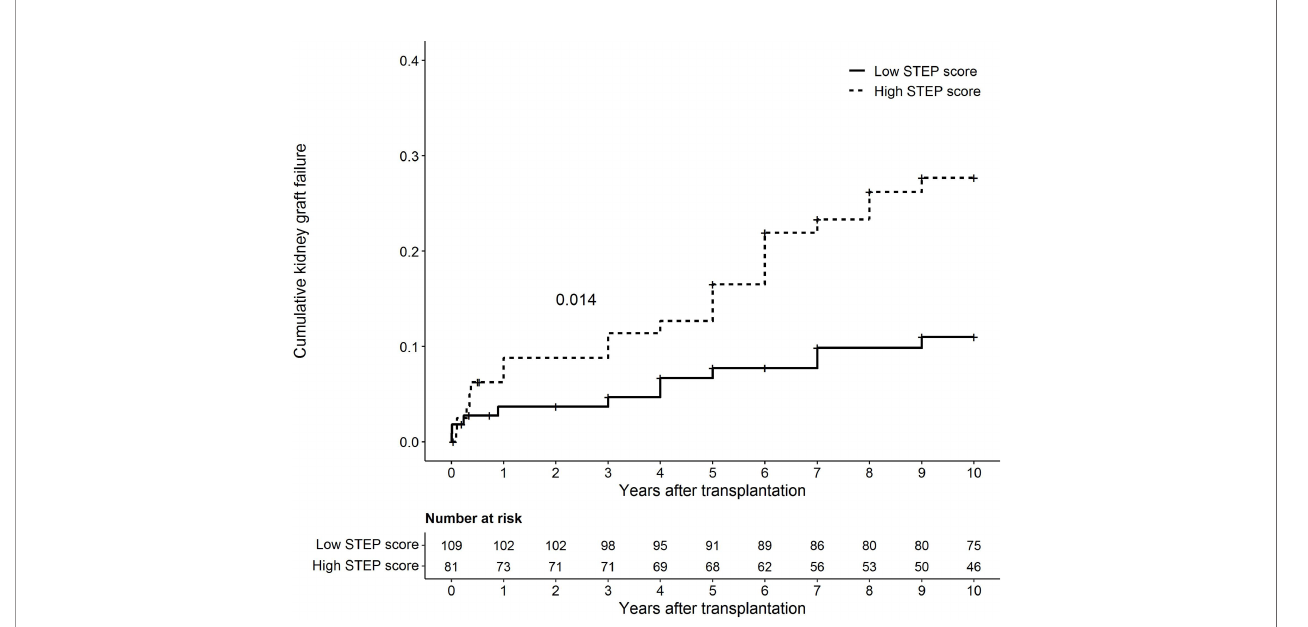
FIGURE 4 | Cumulative 10-year death-censored kidney graft failure incidence among recipients with a low Shared T-cell EPitopes (STEP) score ( ≤ 0.21, n = 109, 11 events during follow-up) and recipients with a high STEP score (> 0.21, n = 81, 21 events during follow-up). p =